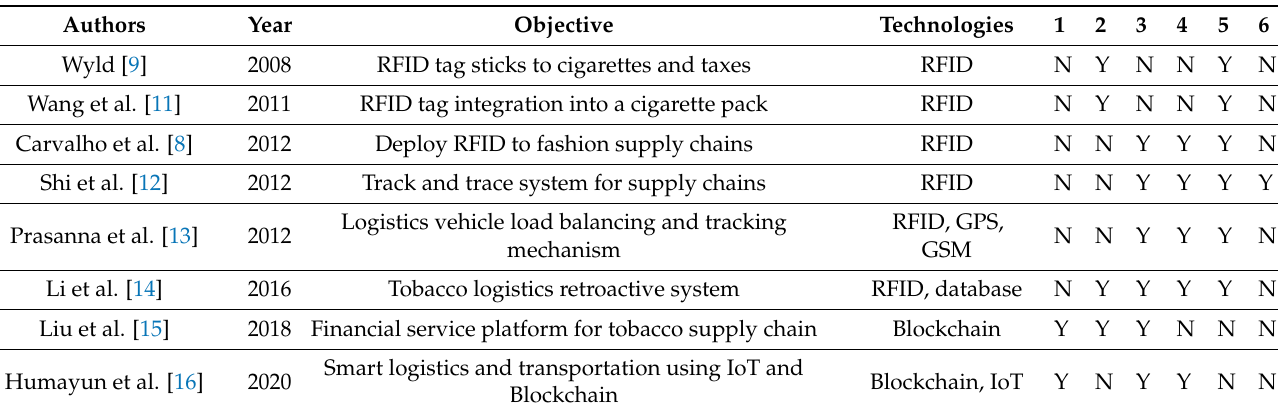
Table 1. Survey of related